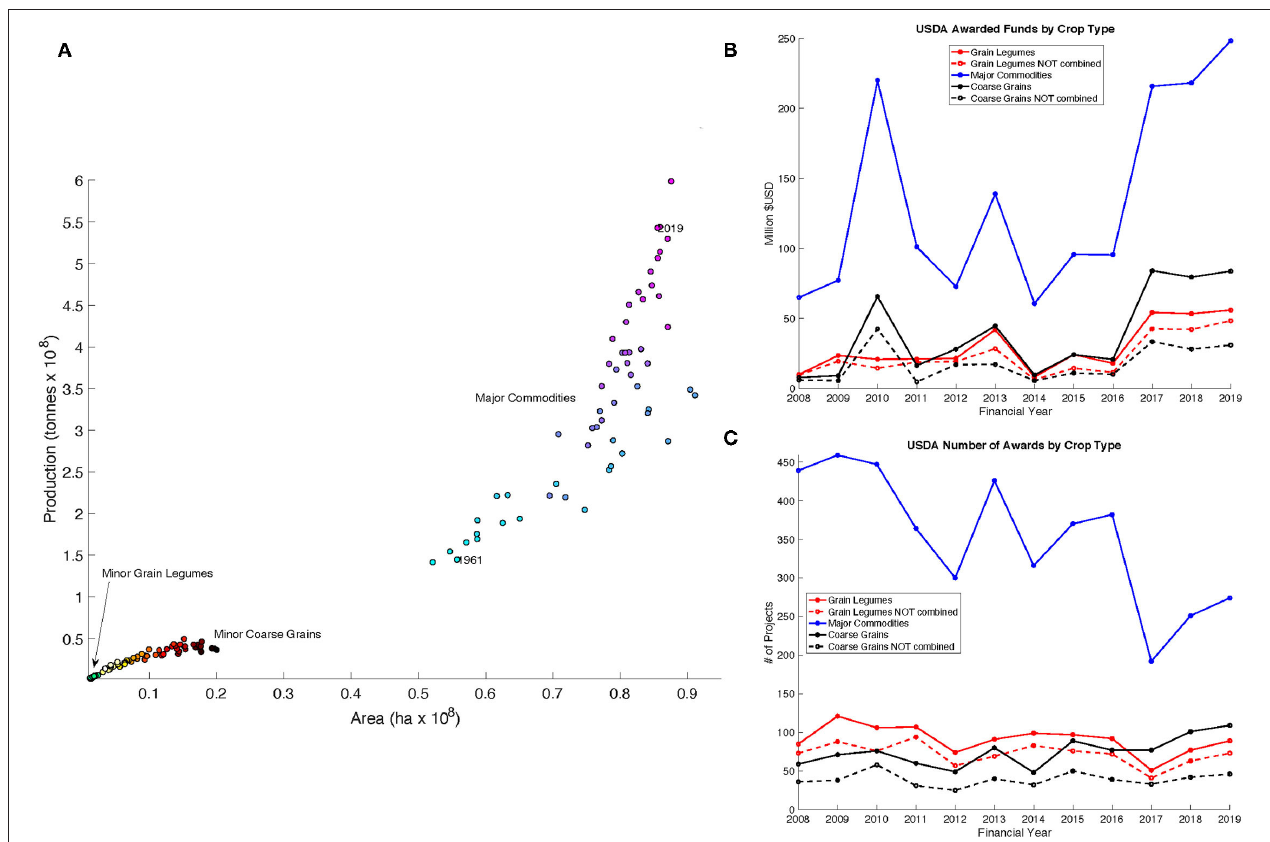
FIGURE 1 | (A) Production vs. Area Planted per crop group ( Table 1 ) in the United States from 1961 to 2019. In panel A, three different color gradients (one for each crop group) are used to represent the temporal dimension. For major commodities, light blue indicates earlier years while bright pink represents later years. For minor coarse grains, whose area is declining, darker reds represent earlier years while white/yellow represents later years. Minor grain legumes are shown in green (no gradient), and there is little change over time in both production and area planted. Data is obtained from FAOSTAT. (B) Total USDA awarded funds made annually from 2008 to 2019 to grain legumes, coarse grains, and major commodities ( Table 1 ) and (C) Number of USDA awards made annually by crop group. Grain legumes NOT combined and Coarse Grains NOT combined (dashed lines) excludes maize, rice, wheat, and soy. Grant data was obtained from the Federal RePORTER database (https://federalreporter.nih.gov) using a regular expression approach with the Advanced Search function based on the crops listed in Table 1 . These searches yielded 4,220 funded projects on major commodity crops, 896 funded projects on minor coarse grains, and 1,089 funded projects on minor grain legumes. We note that not all US government agencies reported consistently to Federal RePORTER from 2008 to 2019. As such, it is possible that funding levels for all crop species may be higher than what is shown